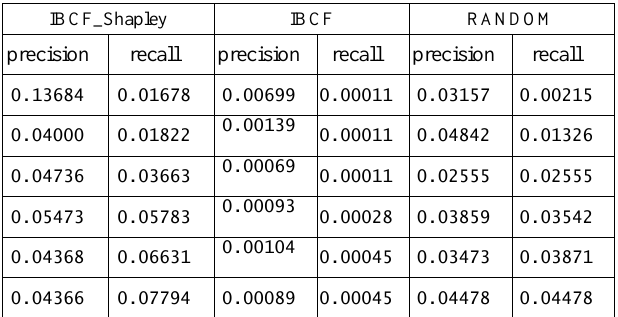
Table 7. The values of precision/recall of three models on